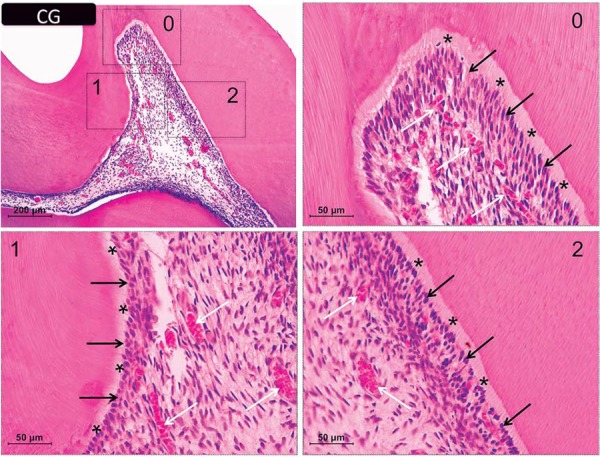
 Representative images of H&E-stained sections with controls’ coronal pulp. Panels 0, 1, and 2 are magnified images (×400) of the respective insets in the upper left panel (×100 magnification). Black arrows indicate the odontoblastic layer and white arrows show the distribution of cells and blood vessels in the subjacent tissue. Asterisks show the predentin layer. H&E=hematoxylin & eosin